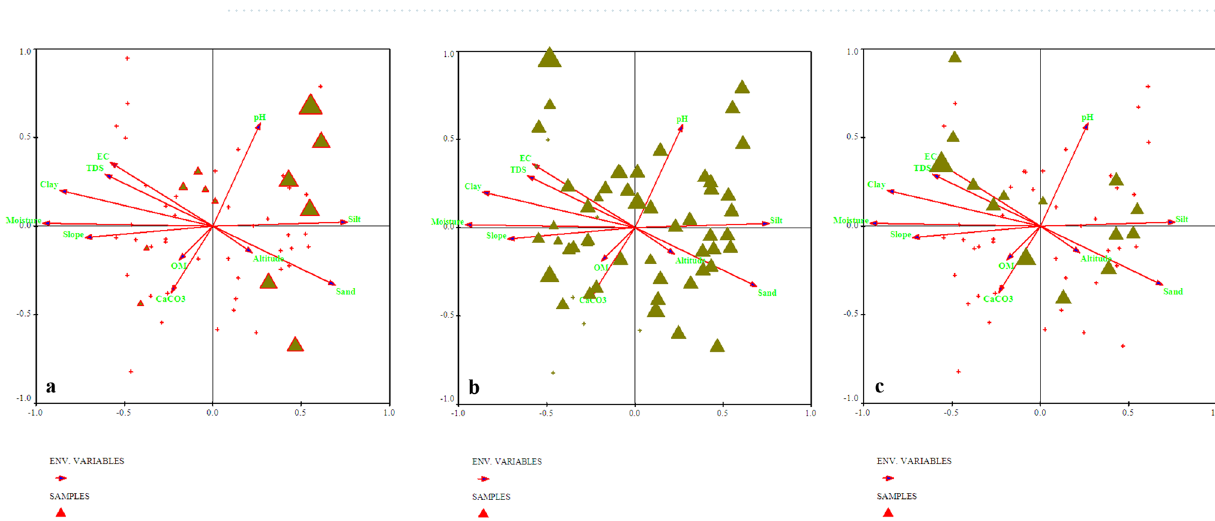
Figure 7. Indicator species biplot for ( a ) Quercus incana , ( b ) Boxus wallichiana and ( c ) Agrostis gigantea, top 3 indicator plants of 2nd plants community after CCA of Canoco